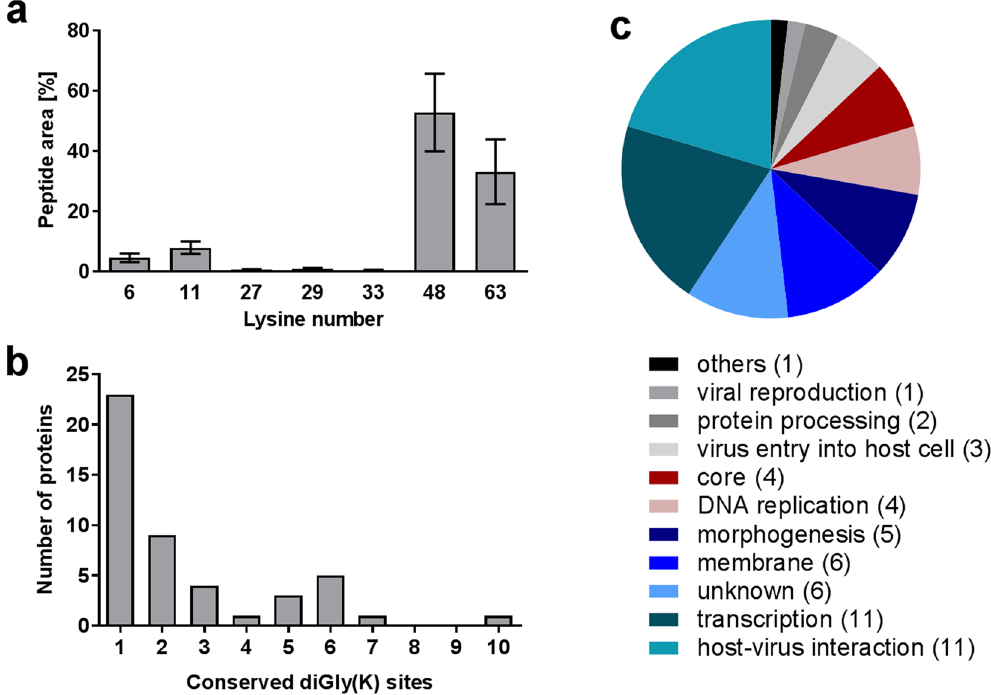
Figure 4. Conserved ubiquitination sites and lysine linkages in CPXV mature virions. ( a ) Quantitative approximation of lysine linkages in CPXV IMV particles using linkage-specific peptide areas. Shown is the mean ± standard deviation of five CPXV strains in % of total ubiquitin diGly(K) peptide area. ( b ) Number of conserved ubiquitination sites in CPXV proteins. ( c ) CPXV proteins with conserved ubiquitination sites grouped by function. Shown is the number of proteins (in parenthesis) associated with a distinct